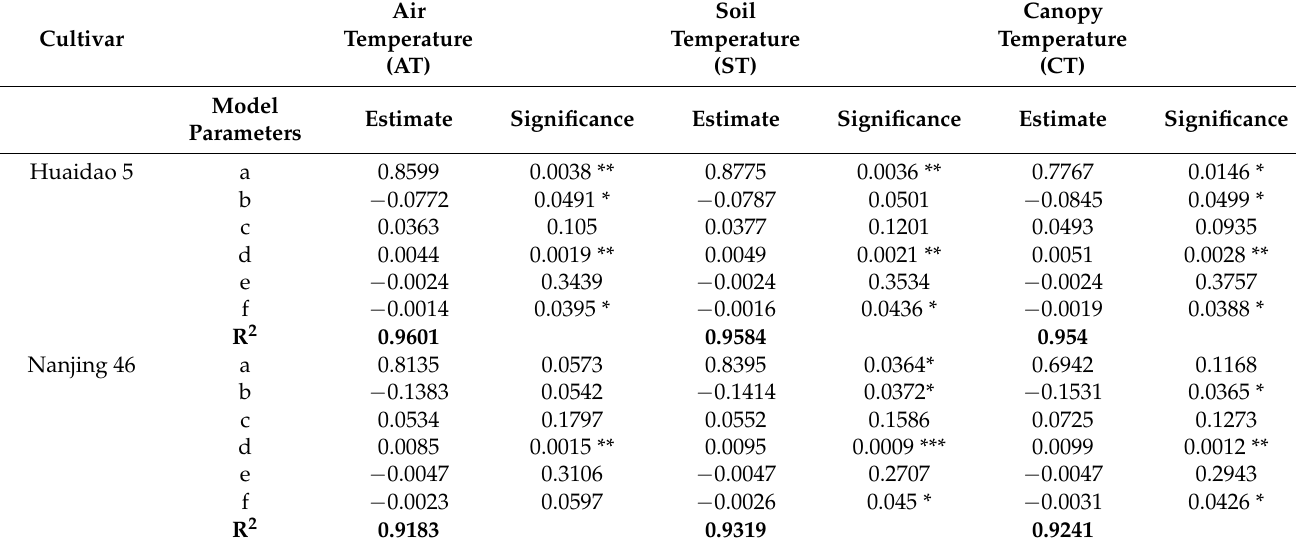
Table 3. Parameters of response surface model (RSM) for the relationship of low air temperature (AT), soil temperature (ST) and canopy temperature (CT) with grain yield of Huaidao 5 and Nanjing 46 at flowering stage under varied low- temperature